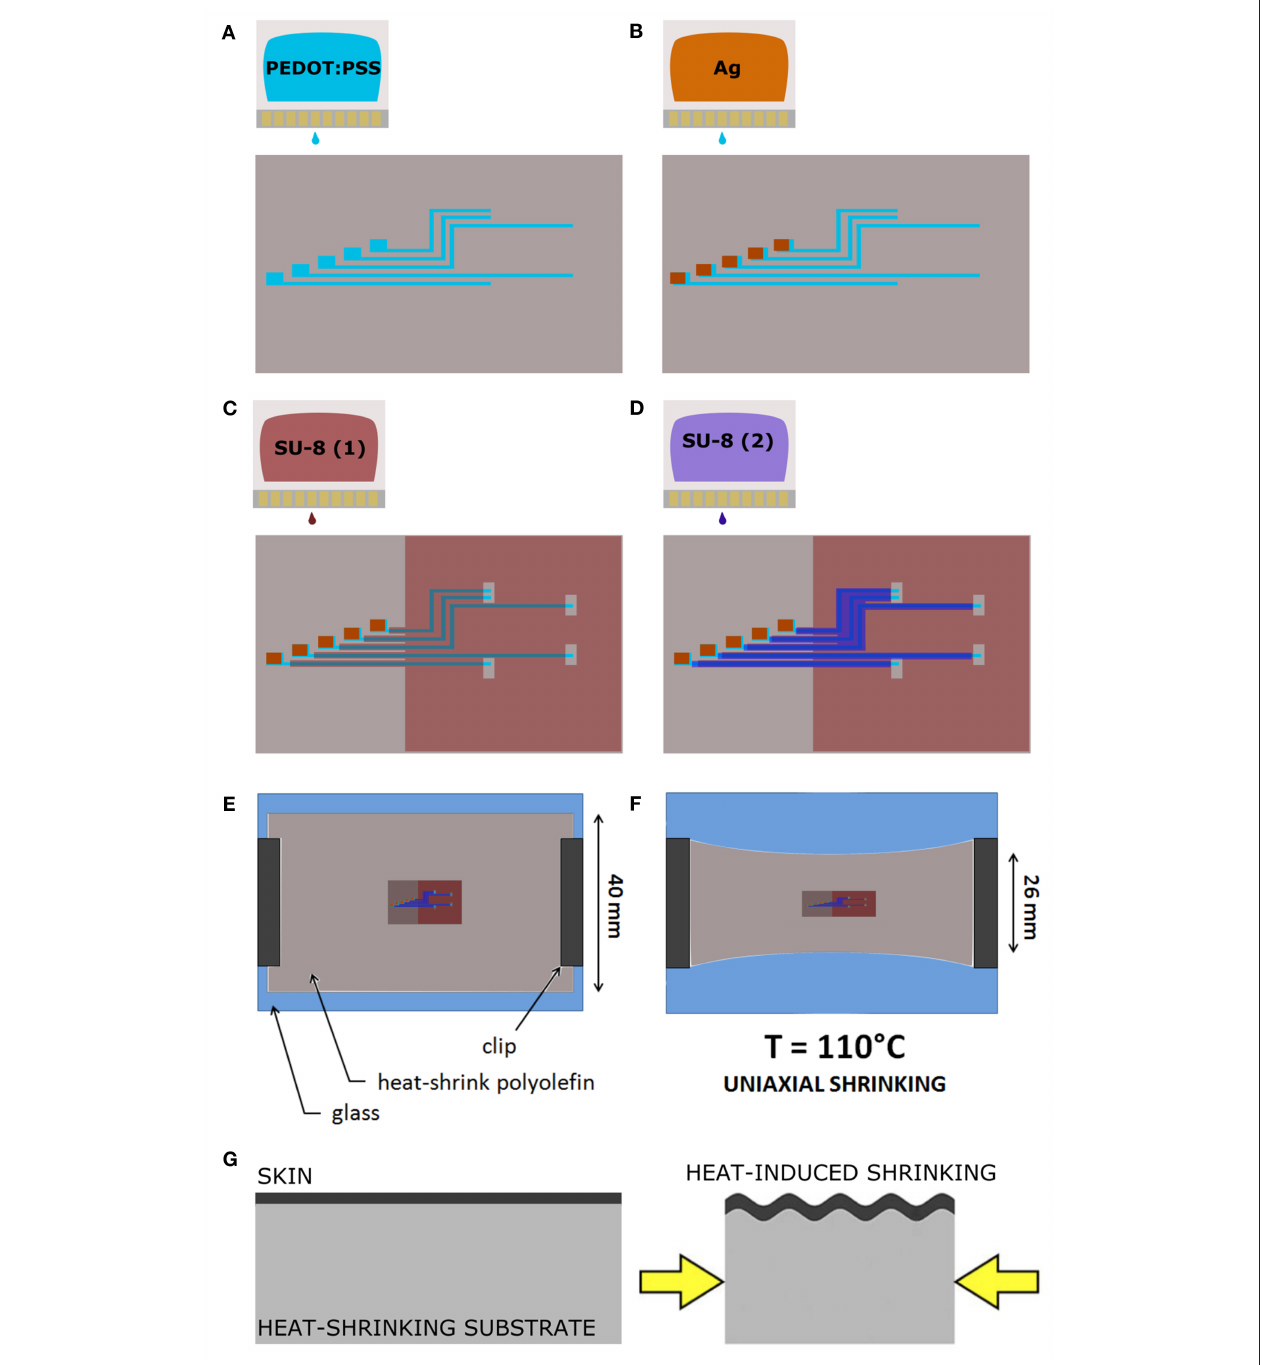
FIGURE 1 | The Print and Shrink fabrication process. (A) Inkjet printing of the conductive ink based on PEDOT:PSS. (B) Inkjet printing of the Ag ink. (C) Inkjet printing of the first SU-8 10% layer. (D) Inkjet printing of the SU-8 29% layer. (E) PO film clamped onto the glass slide. (F) Thermally-induced uniaxial shrinking. (G) Schematics of surface wrinkling induced by